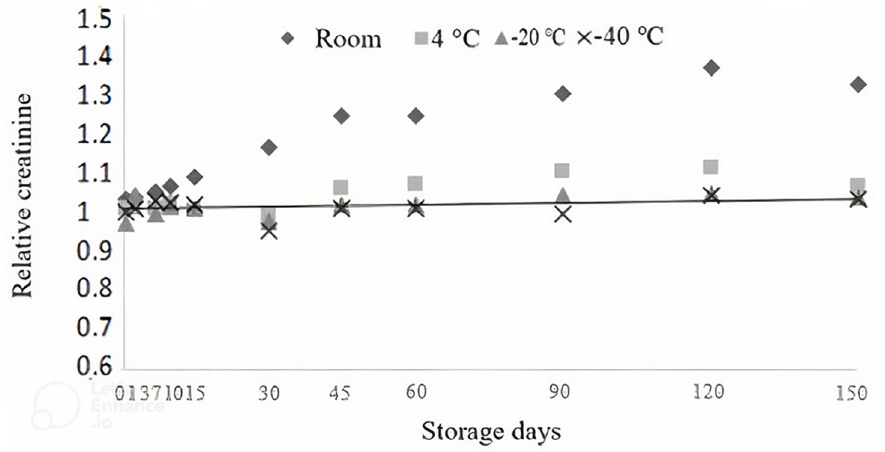
Fig 2. Relative creatinine concentration in cattle urine as a function of time (days) and temperature